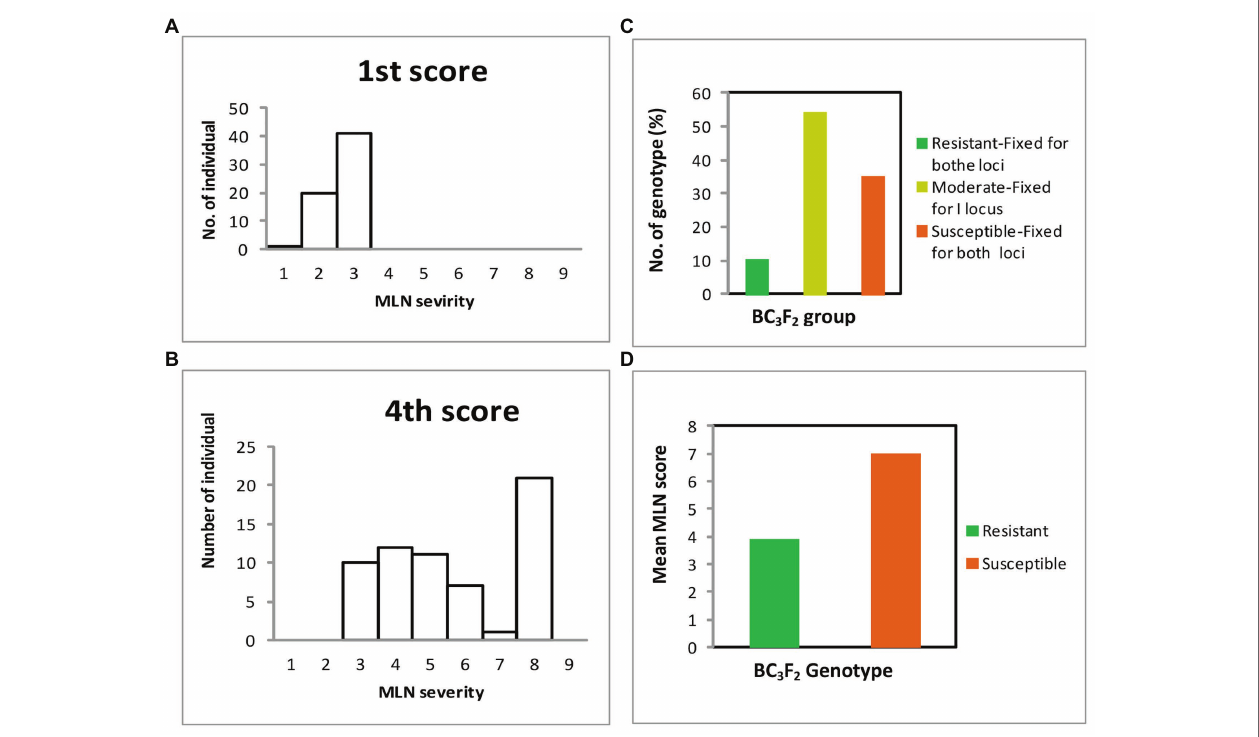
FIGURE 5 | Responses of BC 3 F 2 lines to MLN infections in the field recorded at scale of 1–9: (A) mean distribution of MLN severity for first score; (B) mean distribution of MLN severity fourth score; (C) mean distribution of MLN scores for resistant, moderate, and susceptible genotypes; and (D) mean distribution of MLN scores for resistant and susceptible groups of